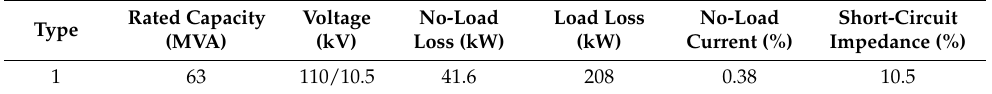
Table 16. Specifications of a two-winding oil-immersed transformer.